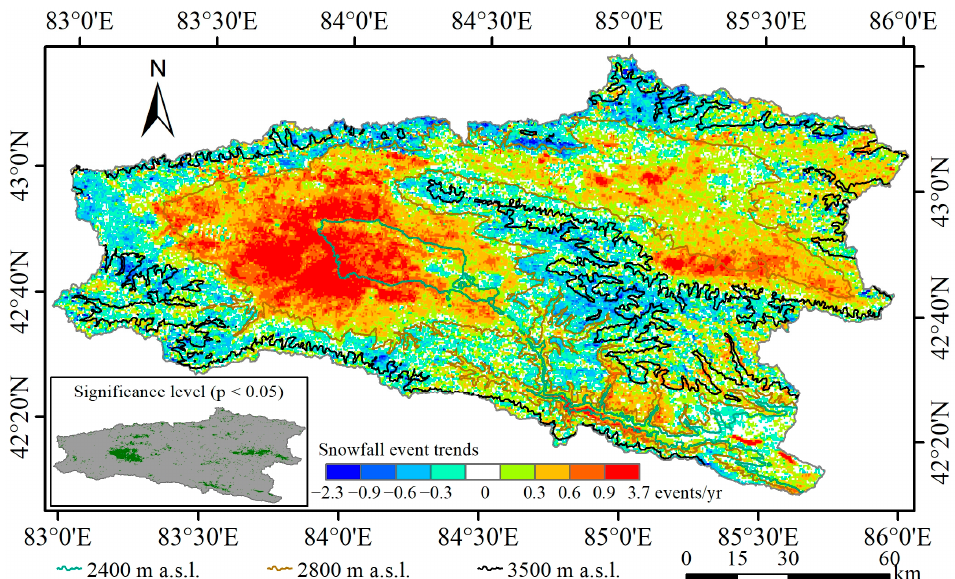
Figure 8. The spatial distribution of the annual trend in the number of snowfall events over the Kaidu River Basin from June 2000 to May 2020, where the green areas in the inset figure represent significant trends at a 95% ( p < 0.05) confidence level.